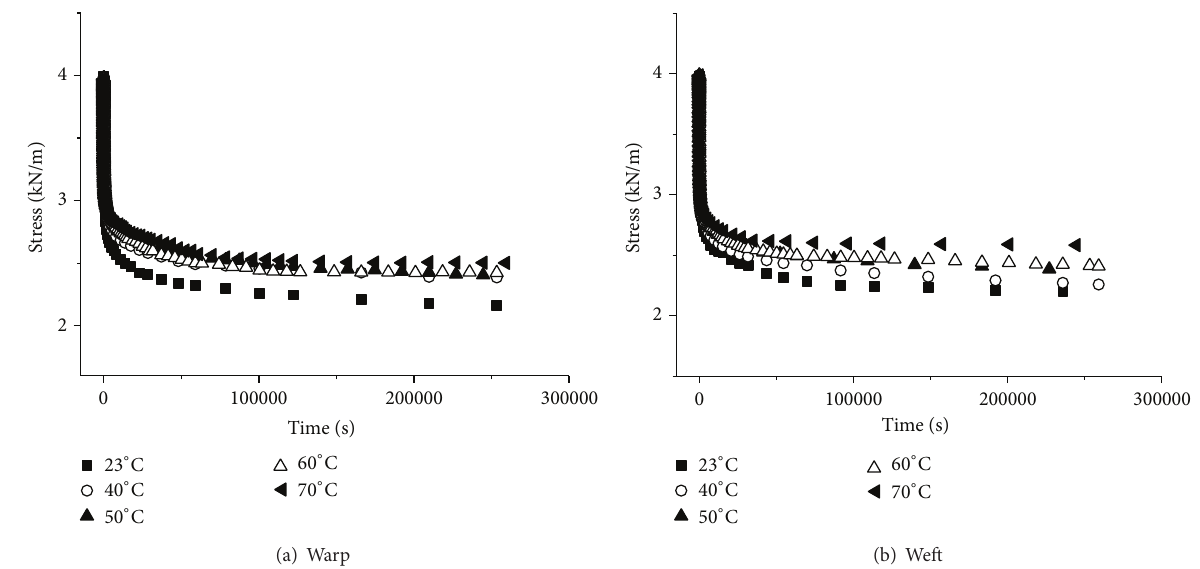
Figure 6: Stress-relaxation curves of PTFE coated fabrics under different temperatures.